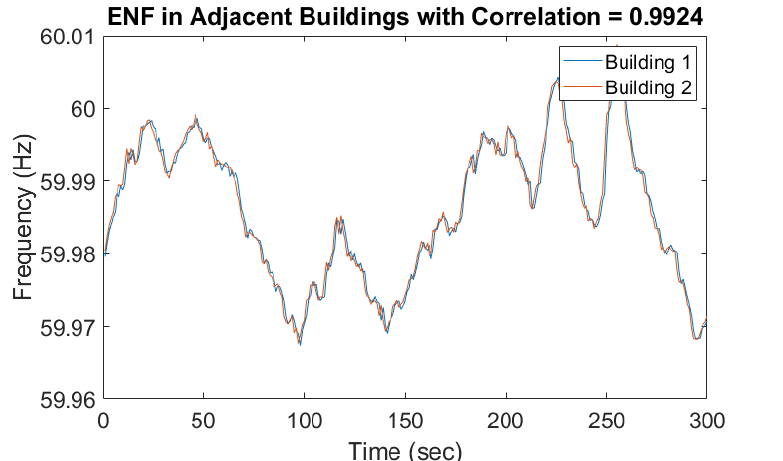
Figure 4. ENF captured in adjacent